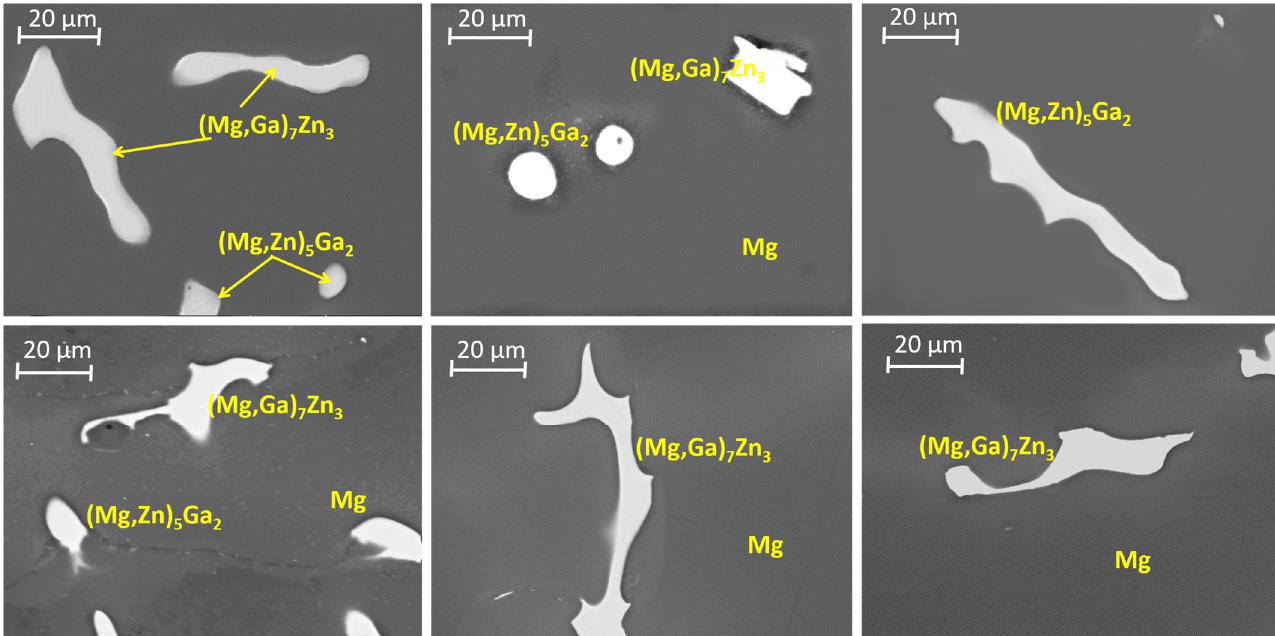
Figure 2. SEM images showing second phases (intermetallics) found in the as-cast Mg-Ga-Zn alloys.